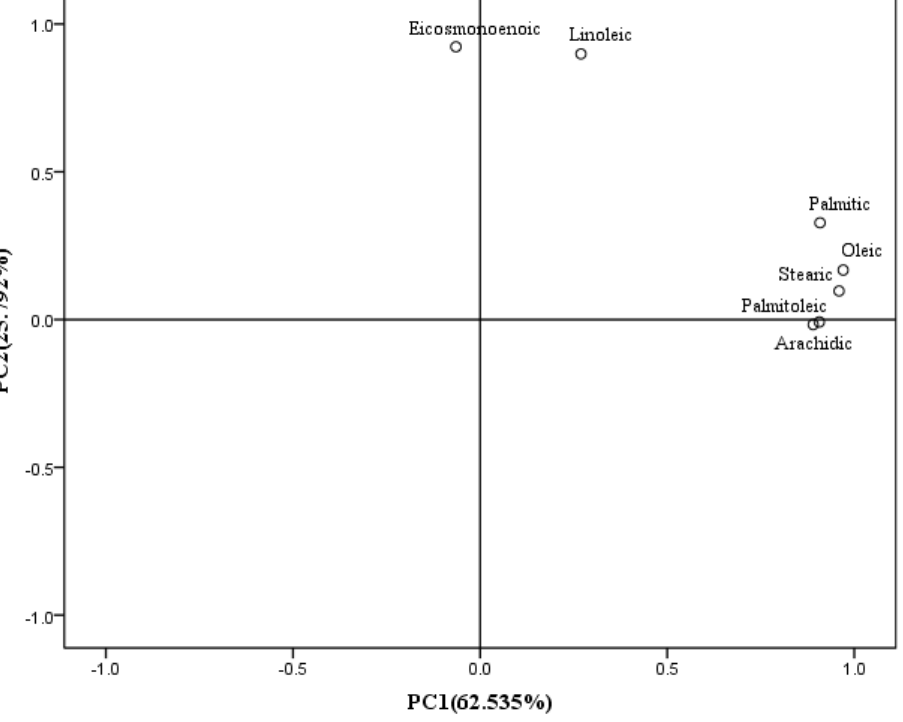
Table 8. Weight of different fatty acids in the quality evaluation of fresh sweet-waxy corn. Fatty Acids